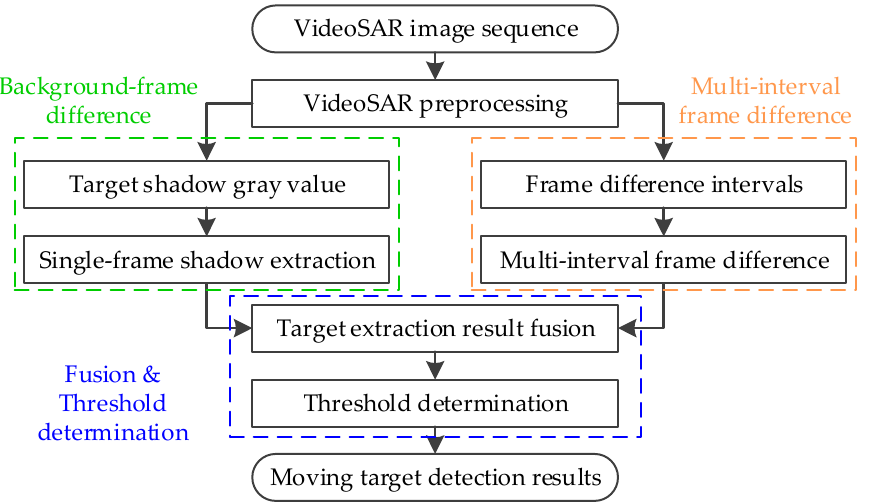
Figure 3. Flowchart of the proposed VideoSAR-based MTD algorithm. The green box represents the background frame detection step, the orange box represents the multi-interval frame difference step, and the blue box represents the fusion and threshold determination